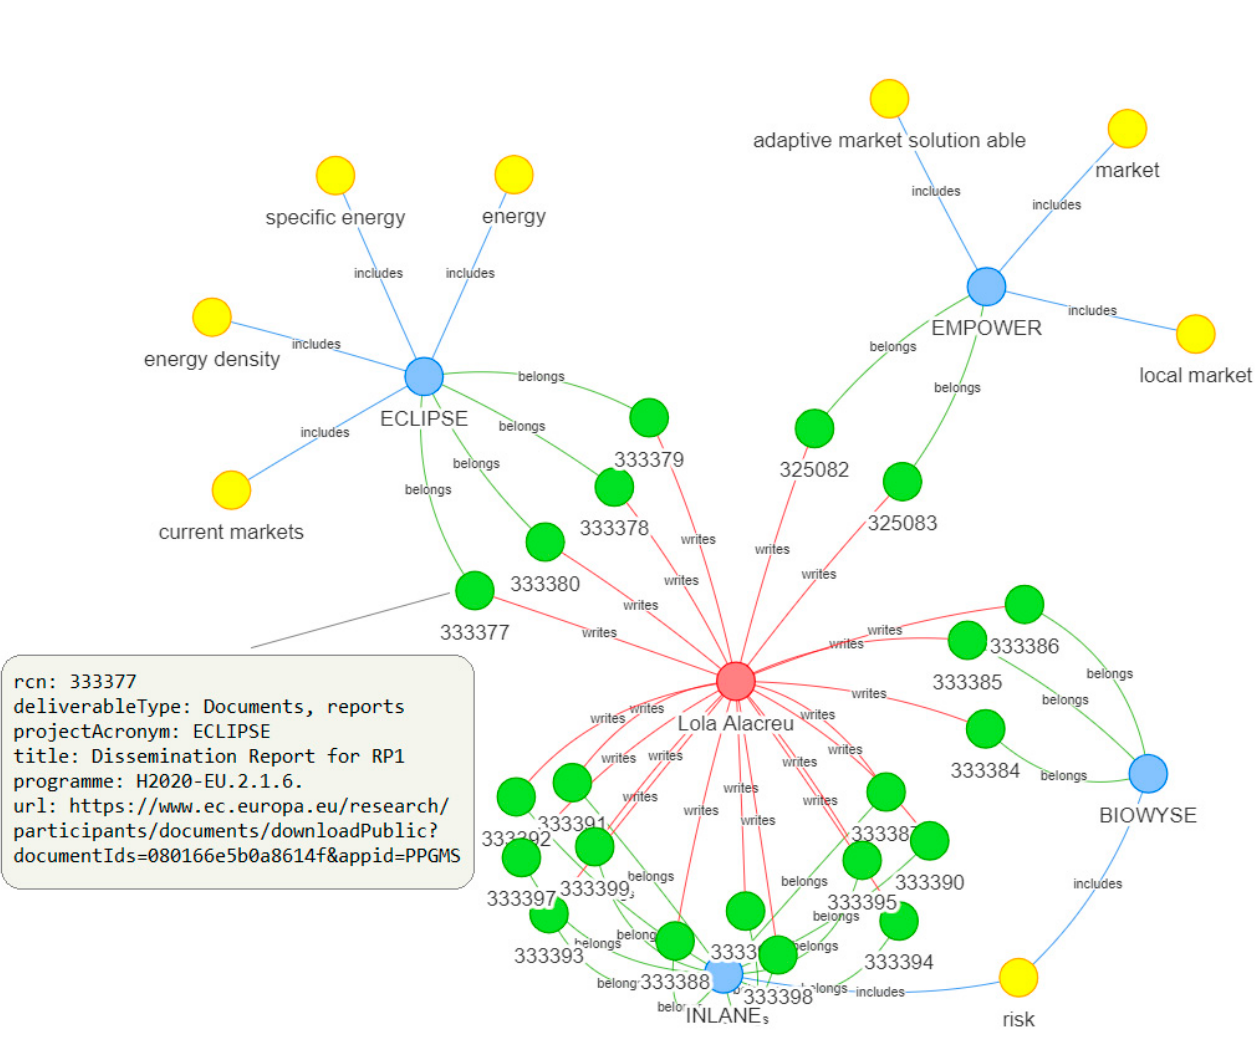
Figure 6. Visualization of a specific person and some of the associated projects, deliverables, and keyphrases.